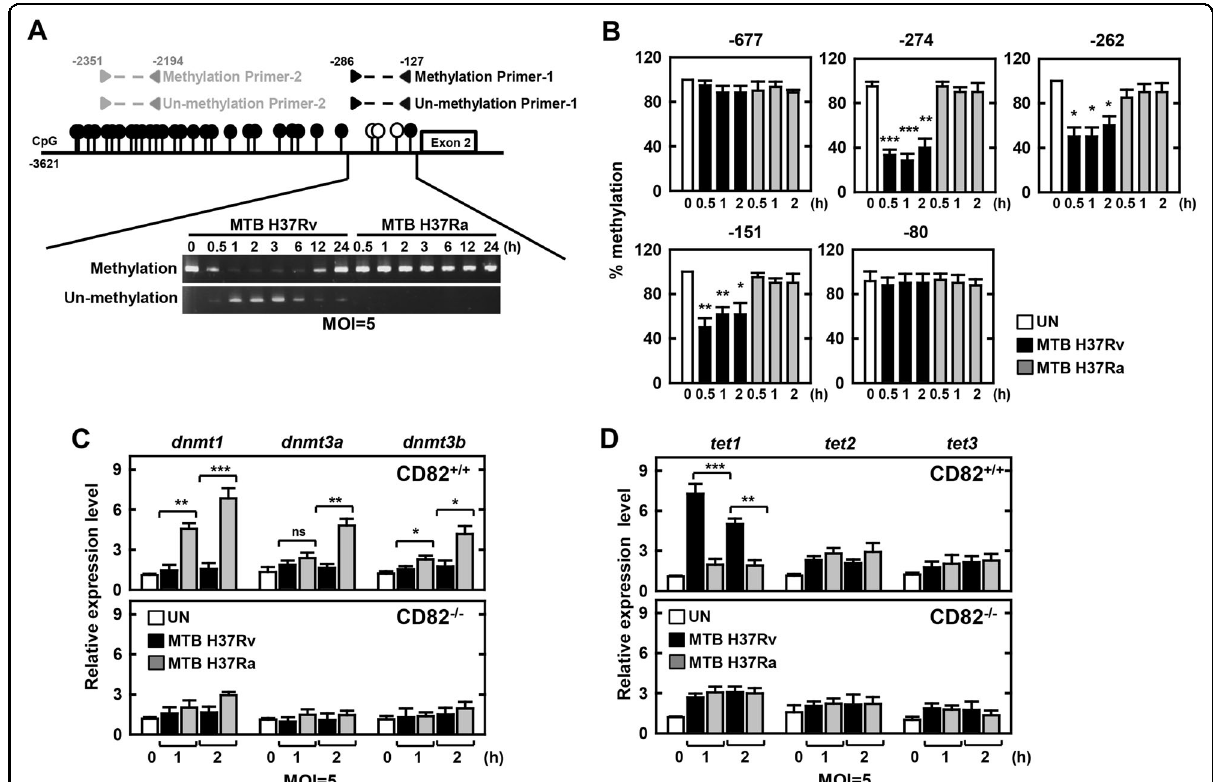
Fig. 4 Methylation analysis of CD82 promoter region during MTB infection. a Schematic illustration of the CD82 promoter region. The CpG island map is indicated in the top panel, and the sequence ampli fi ed for methylation analysis is shown in the bottom panel. BMDMs were infected with MTB Rv or MTB Ra for the indicated times, followed by PCR with methylation or non-methylation primers. b Methylation status of CpG sites was measured by direct sodium bisulfate DNA sequencing as in the Supplementary Methods. Methylation status of − 677, − 274, − 262, − 151, or − 80 regions was analyzed. At least 10 clones were sequenced for each group. c , d BMDMs from CD82 + / + and CD82 − / − were infected with MTB Rv or MTB Ra for the indicated times. Real-time qPCR analysis of dnmt or tet expression. The data are representative of fi ve independent experiments with similar results ( a ). Data shown are the means ± SD of fi ve experiments ( b – d ). Signi fi cant differences (* P < 0.05; ** P < 0.01; *** P < 0.001) compared